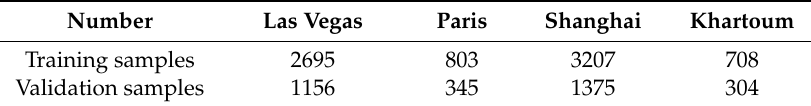
Table 2. Number of training and validation samples in four cities.